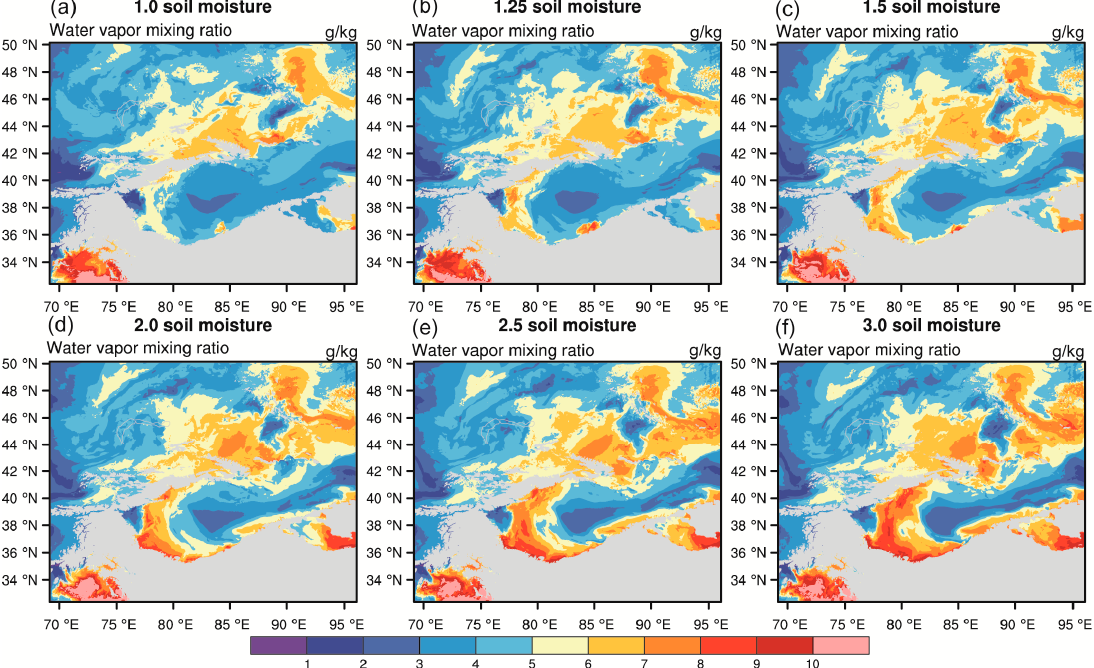
Figure 6. The specific humidity of 700-hPa at 002 UTC 17 August 2019 of the WRF simulations under different soil moisture initial conditions. ( a ) 1.0; ( b ) 1.25; ( c ) 1.5; ( d ) 2.0; ( e ) 2.5; and ( f ) 3.0 multiples of NCEP GFS soil moisture represent ( a ) “1.0 soil moisture”; ( b ) “1.25 soil moisture”; ( c ) “1.5 soil moisture”; ( d ) “2.0 soil moisture”; ( e ) “2.5 soil moisture”; and ( f ) “3.0 soil moisture”, respectively.